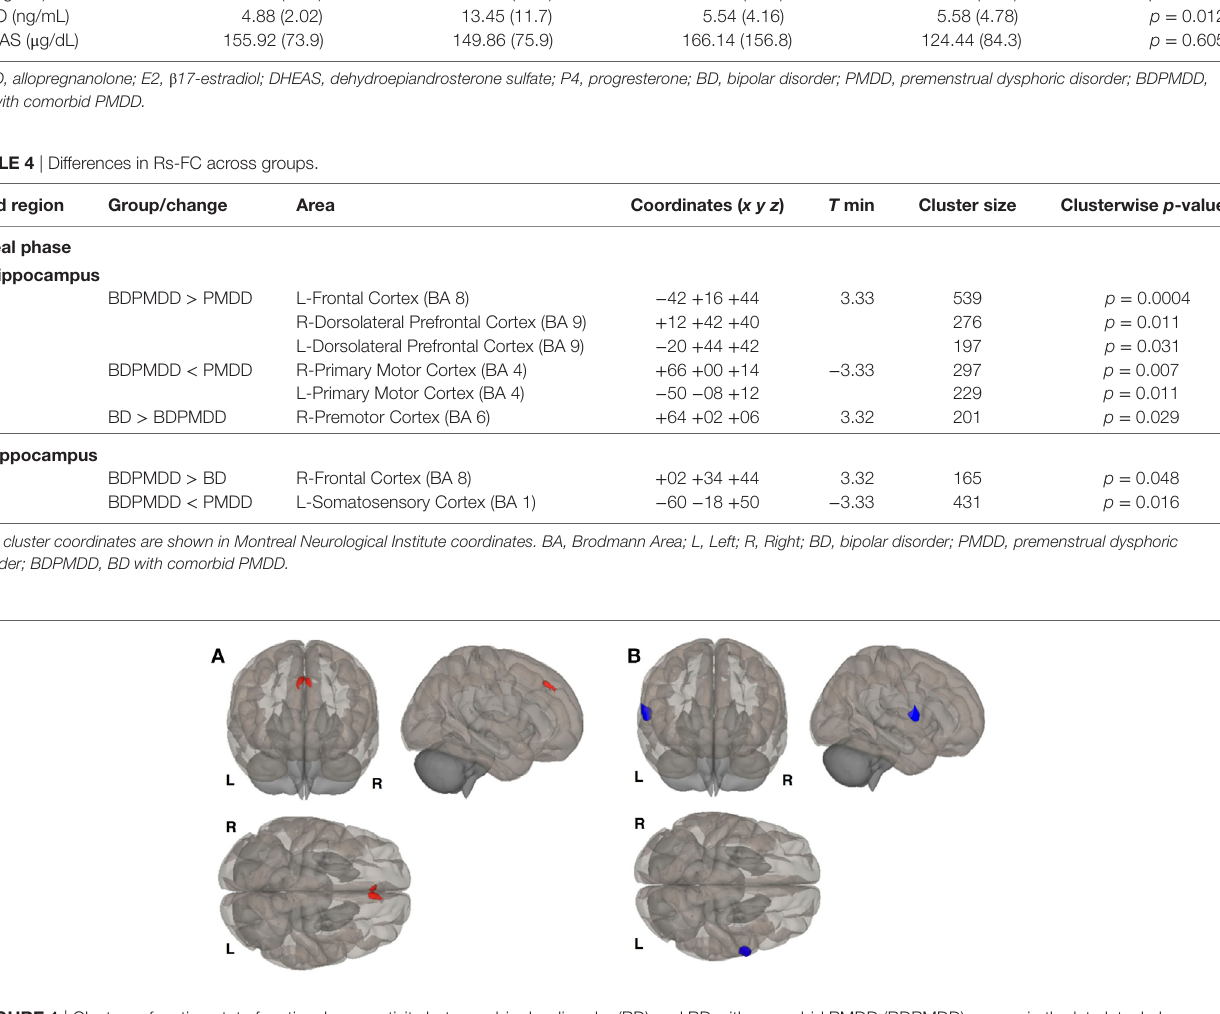
FigUre 1 | Clusters of resting state functional connectivity between bipolar disorder (BD) and BD with comorbid PMDD (BDPMDD) groups in the late luteal phase. (a) Increased connectivity in between the left hippocampus (seed) and right frontal cortex ( k = 165; X = + 02, Y = + 34, Z = + 44; p = 0.048, FDR-corrected), BDPMDD compared to BD. (B) Decreased connectivity between the right hippocampus (seed) and the left premotor cortex ( k = 201; X = + 64, Y = + 02, Z = + 06; p = 0.029, FDR-corrected) in BDPMDD compared to BD. Statistical details are shown in Table 4